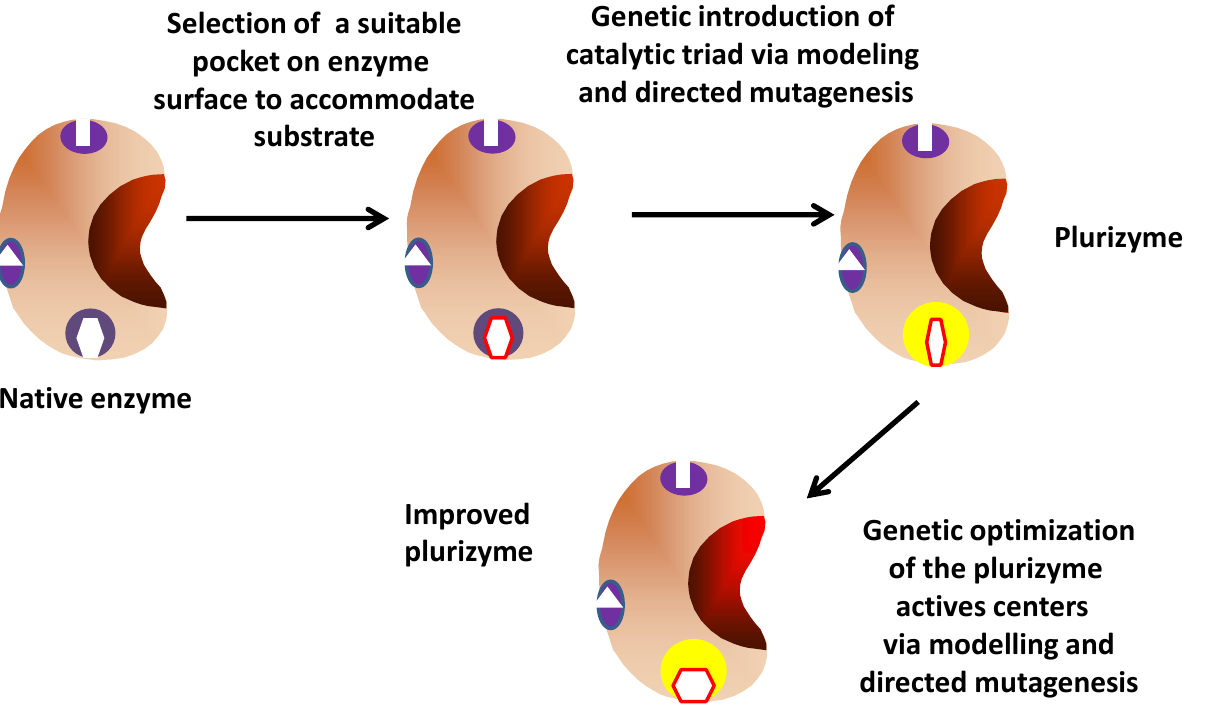
Figure 7. Design and optimization of